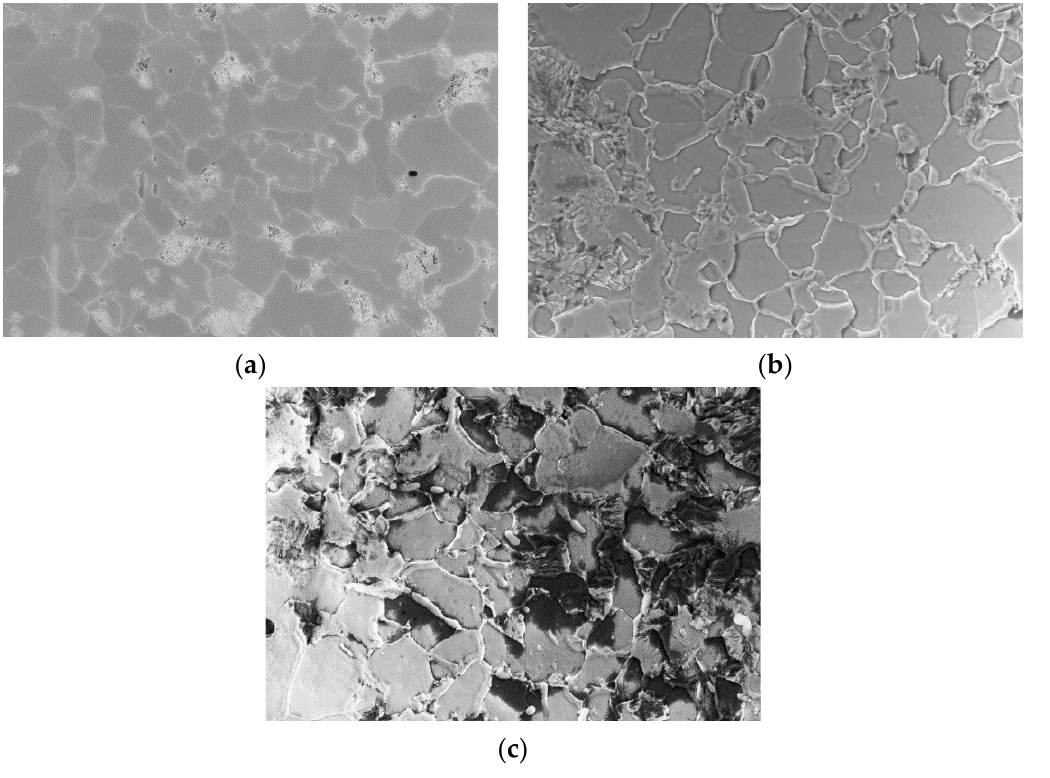
Figure A3. Example of a microstructure surface with different etching times: ( a ) 2 s, ( b ) 5 s, ( c ) 15 s. Various scanning electron microscope modules such as SE (Figure A4a) and “InLens” (Figure A4b) were used.